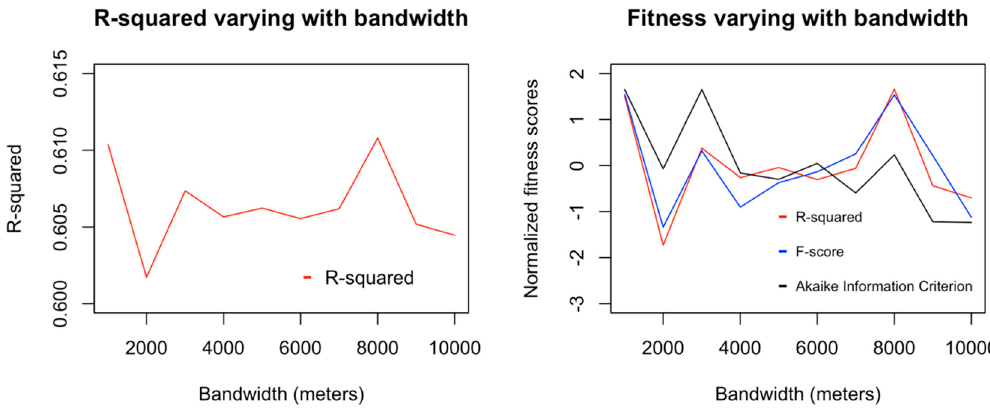
Figure 7. Model fitness varying with the bandwidth chosen for the case of burglary risk at houses. To the left, the R-squared metric is shown; to the right, three fitness scores (R-square, F-score, Akaike information criterion), normalized in value, are compared.